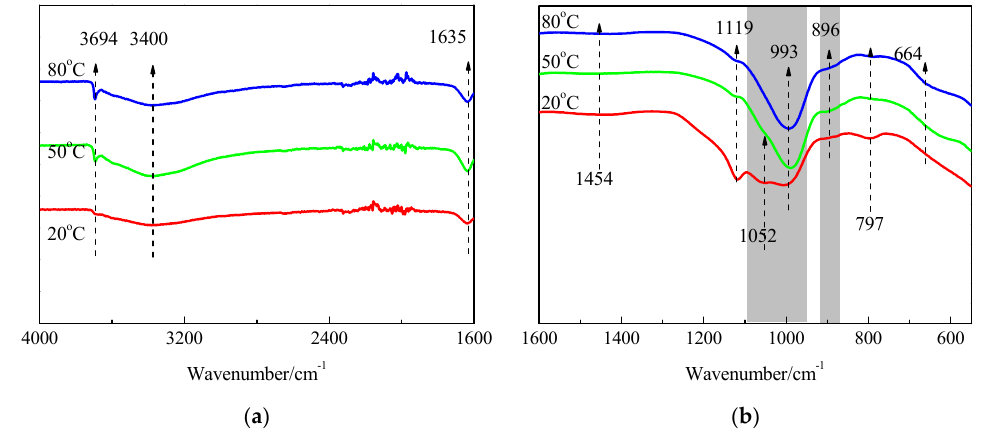
Figure 17. FTIR spectra of MgO-SF pastes prepared using MgO calcined at 1450 °C for 2 h after 28 d: ( a ) 4000 cm − 1 –1600 cm − 1 and ( b ) 1600 cm − 1 –550 cm − 1 . ( a ) 4000 cm − 1 –1600 cm − 1 and ( b ) 1600 cm − 1 –550 cm − 1